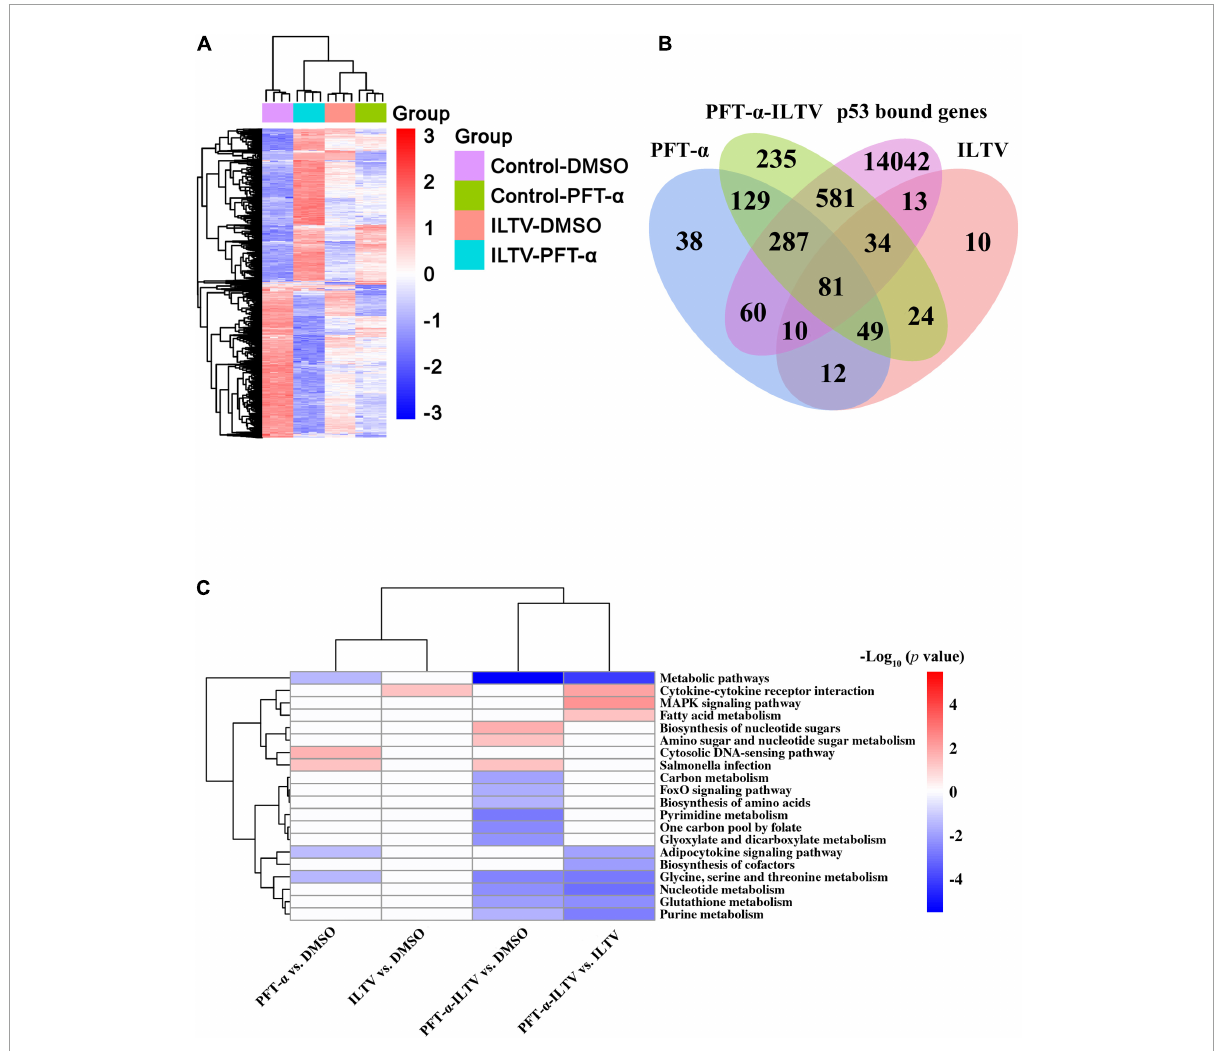
FIGURE3 Genome-wide transcriptome analyses. (A) Hierarchical clustering analysis of 1,595 genes differentially expressed in LMH cells at p- value < 0.05, | log 2 fold change | > 1. Columns indicate arrays, and rows indicate genes. Values are normalized by row. Blue indicates repression, and red indicates promotion. (B) Bioinformatic analysis of the genes bound by p53 and differentially expressed in mock cells or ILTV-infected cells upon PFT- α or DMSO treatment. These DEGs of PFT- α treatment group, ILTV treatment group and ILTV-infected cells pretreated with PFT- α intersect with p53 bound genes, respectively. (C) Combined pathway analysis of significantly expressed genes ( p -value < 0.05). Red indicates upregulated gene enrichment pathways, blue indicates downregulated gene enrichment pathways, and white represents unchanged